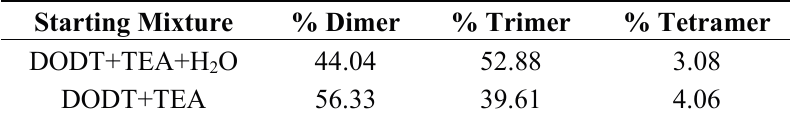
Figure 7. Mass spectrum of the reaction starting with a homogeneous solution of DODT, TEA and water. Table 3. Relative amount of oligomers by ESI-MS.